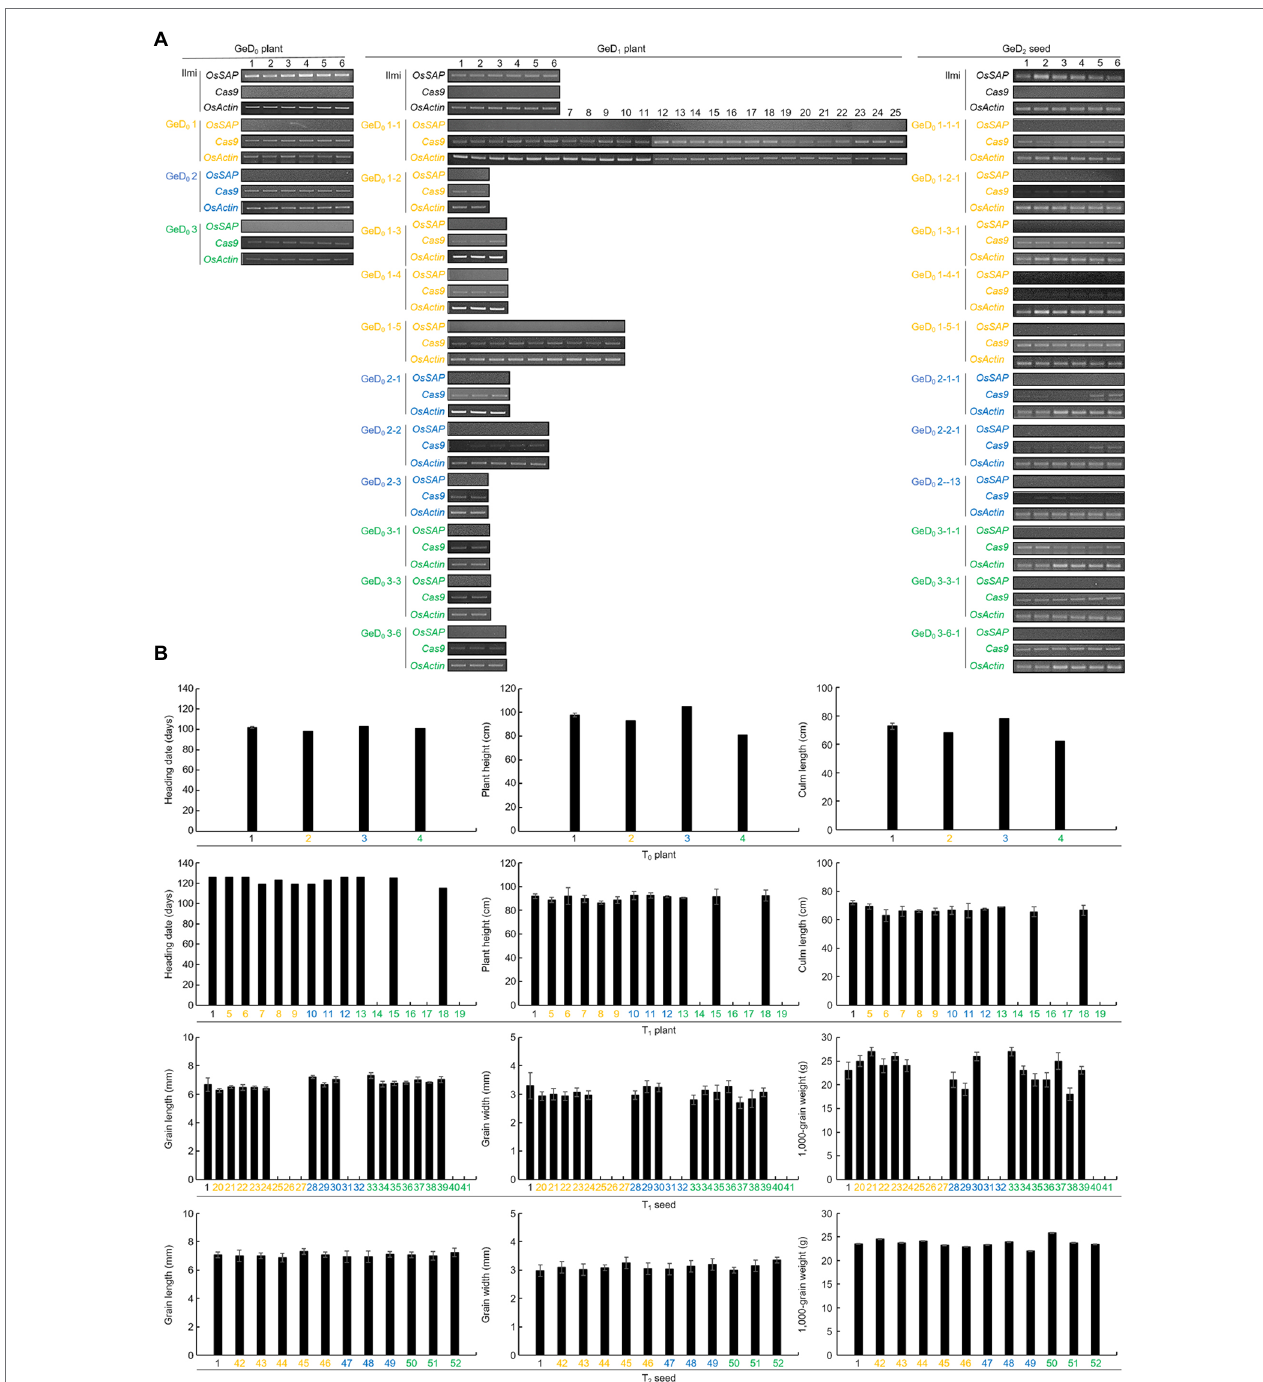
FIGURE 6 | Analysis of the expression level of OsSAP and Cas9 in CRISPR/Cas9-mediated genome-editing lines in each generation through RT-PCR and analysis of agricultural traits of plants and seeds in each generation. (A) Expression levels of OsSAP and Cas9 were analyzed for each line in GeD 0 plants, GeD 1 plants, and GeD 2 seeds, with OsActin used as a control. In the GeD 0 plant, Cas9 expression was very strong in all lines with no expression of OsSAP . In GeD 1 plants, OsSAP was not expressed. However, Cas9 was still strongly expressed, or the expression was weakened. In GeD 2 seeds, OsSAP was not expressed, and Cas9 expression was weakened or maintained. (B) Agricultural traits of plants and seeds in each generation of genome-edited plants with CRISPR/Cas9. Since T 0 plants are each different lines, there is no repeated experiment. T 1 plants which did not germinate or died early in their growth stage were not investigated. T 1 seed numbers were assigned to the tiller of the T 0 plants. Effective tillering was investigated by harvesting the grains, but an accession number was only assigned to the non-productive tiller because there were no grains. For T 2 seeds, grain length, grain width, and 1,000-grain weights were investigated. The 1 on the x-axis is Ilmi. Yellow color: Genome-editing lines using OsSAP -sgRNA1. Blue color: Genome-editing lines using OsSAP -sgRNA2. Green color: Genome-editing lines using OsSAP